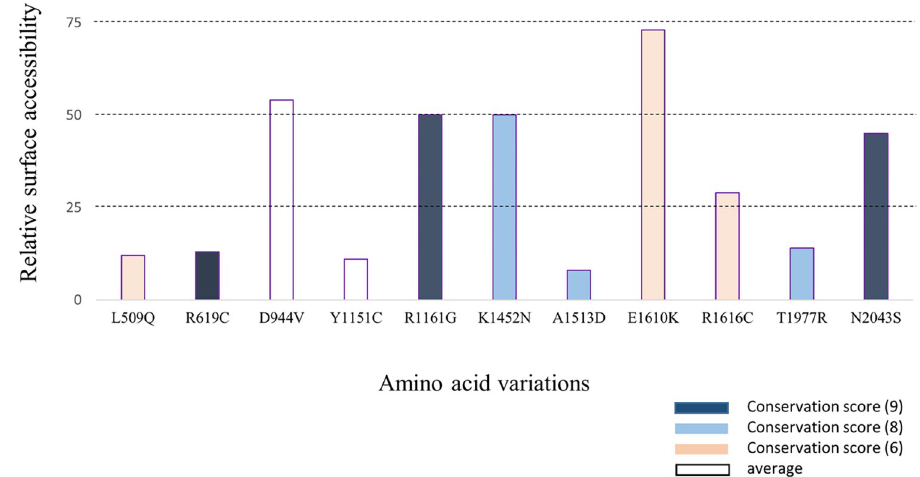
Fig 3. Conservancy and solvent accessibility analysis of selected amino acid positions within mTOR protein. Position of the most deleterious SNPs along with their relative surface accessibility predicted by NetSurfP-2.0 with a threshold of 25% which represents SNPs having > 25% RSA are predicted to be exposed on the protein surface. The conservation state of the SNP positions predicted by ConSurf is represented with color codes.